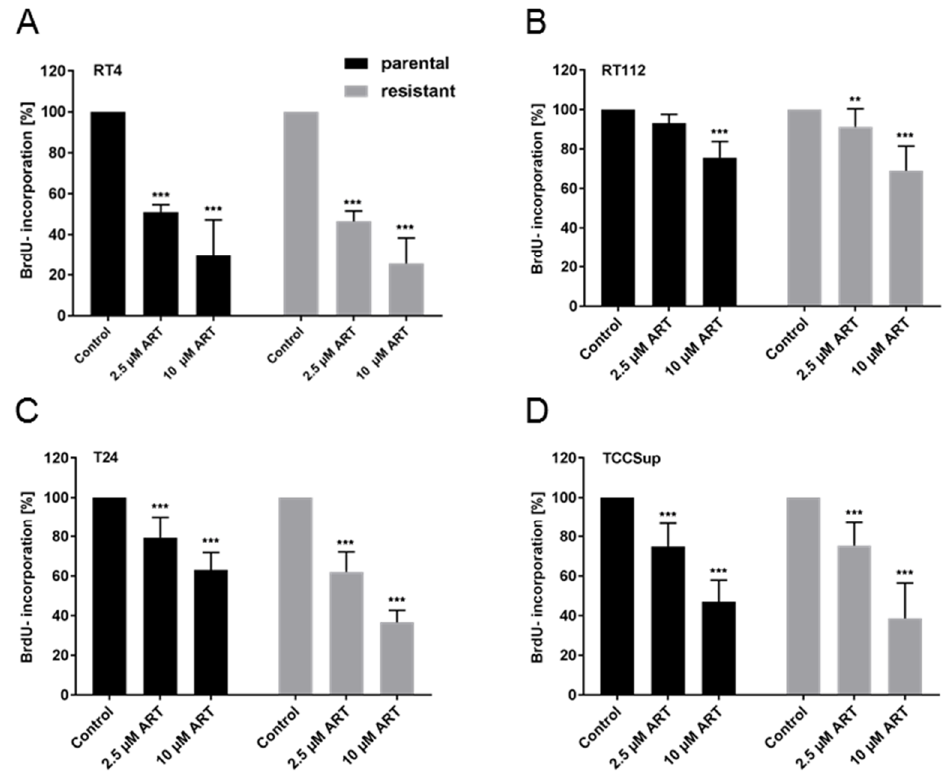
Figure 2. Cell proliferation: Tumor cell proliferation of parental (par) and cisplatin-resistant (res) RT4 ( A ), RT112 ( B ), T24 ( C ), and TCCSup ( D ) cells incubated for 48 h with ART (2.5 or 10 µM). Untreated controls were set to 100%. Error bars indicate standard deviation ( SD ). Significant difference to untreated control: ** p ≤ 0.01, *** p ≤ 0.001. n = 5.